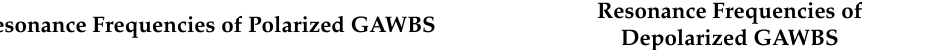
Table 1. Calculated and measured resonance frequencies of the polarized and depolarized GAWBS in silica SMF.